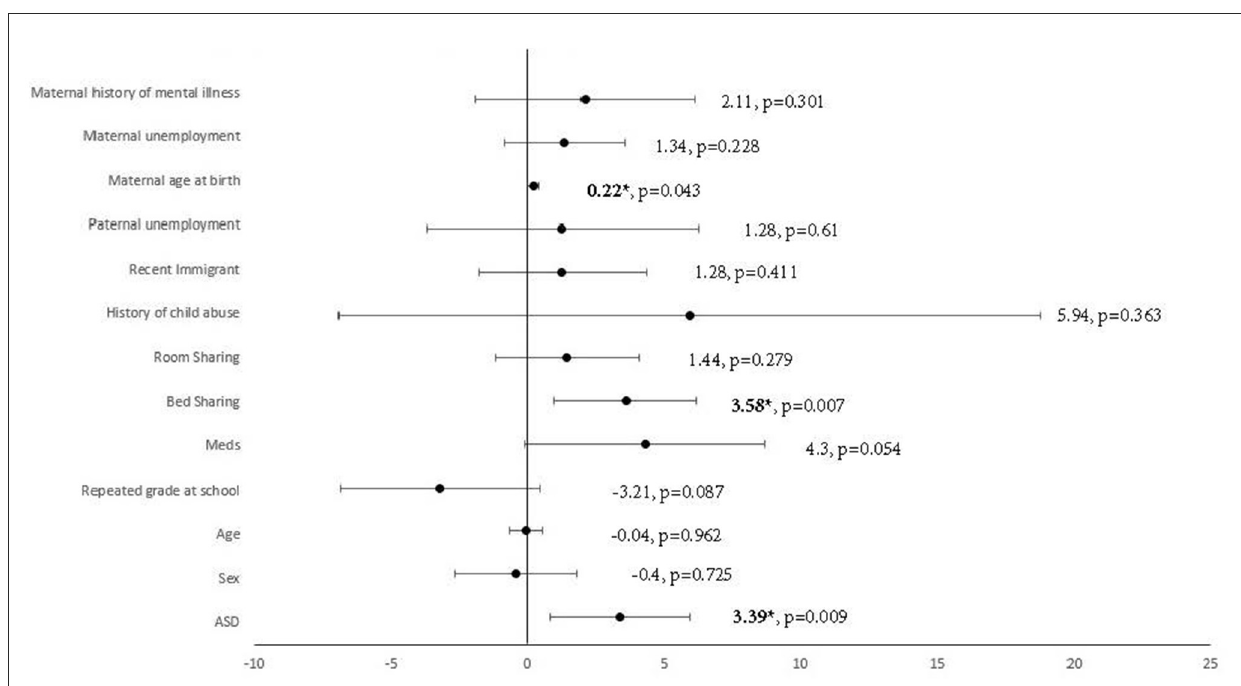
FIGURE2 Multiple linear regression analysis using ASD to predict CSHQ total score, adjusted for demographics factors with significant group differences. * Significant after adjustment of p -value using Benjamin–Hochberg procedure, with a false discovery rate of 10%. Meds, medication; ASD, autism spectrum